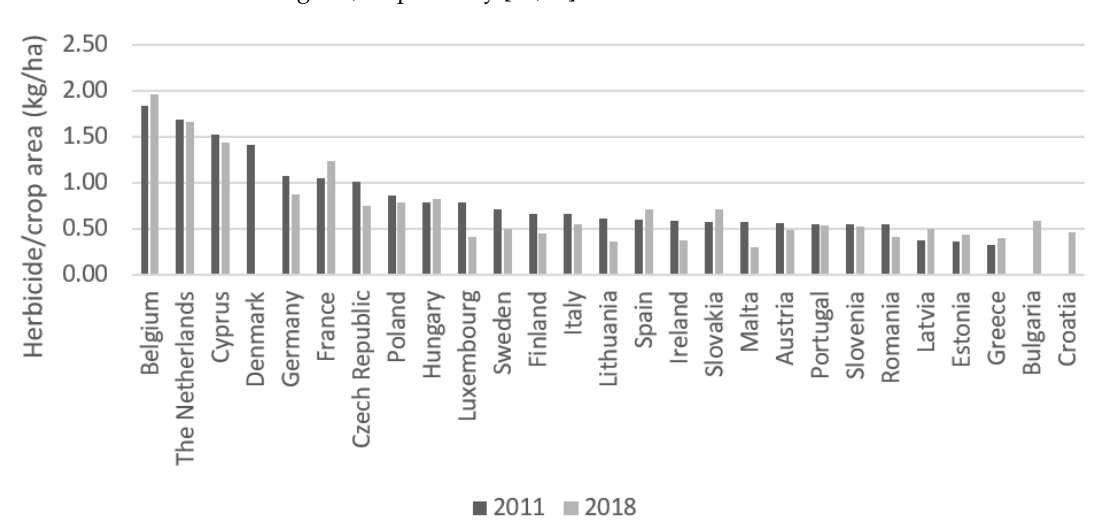
Figure 4. Herbicide use intensity (kg/ha) in the EU between 2011 and 2018.